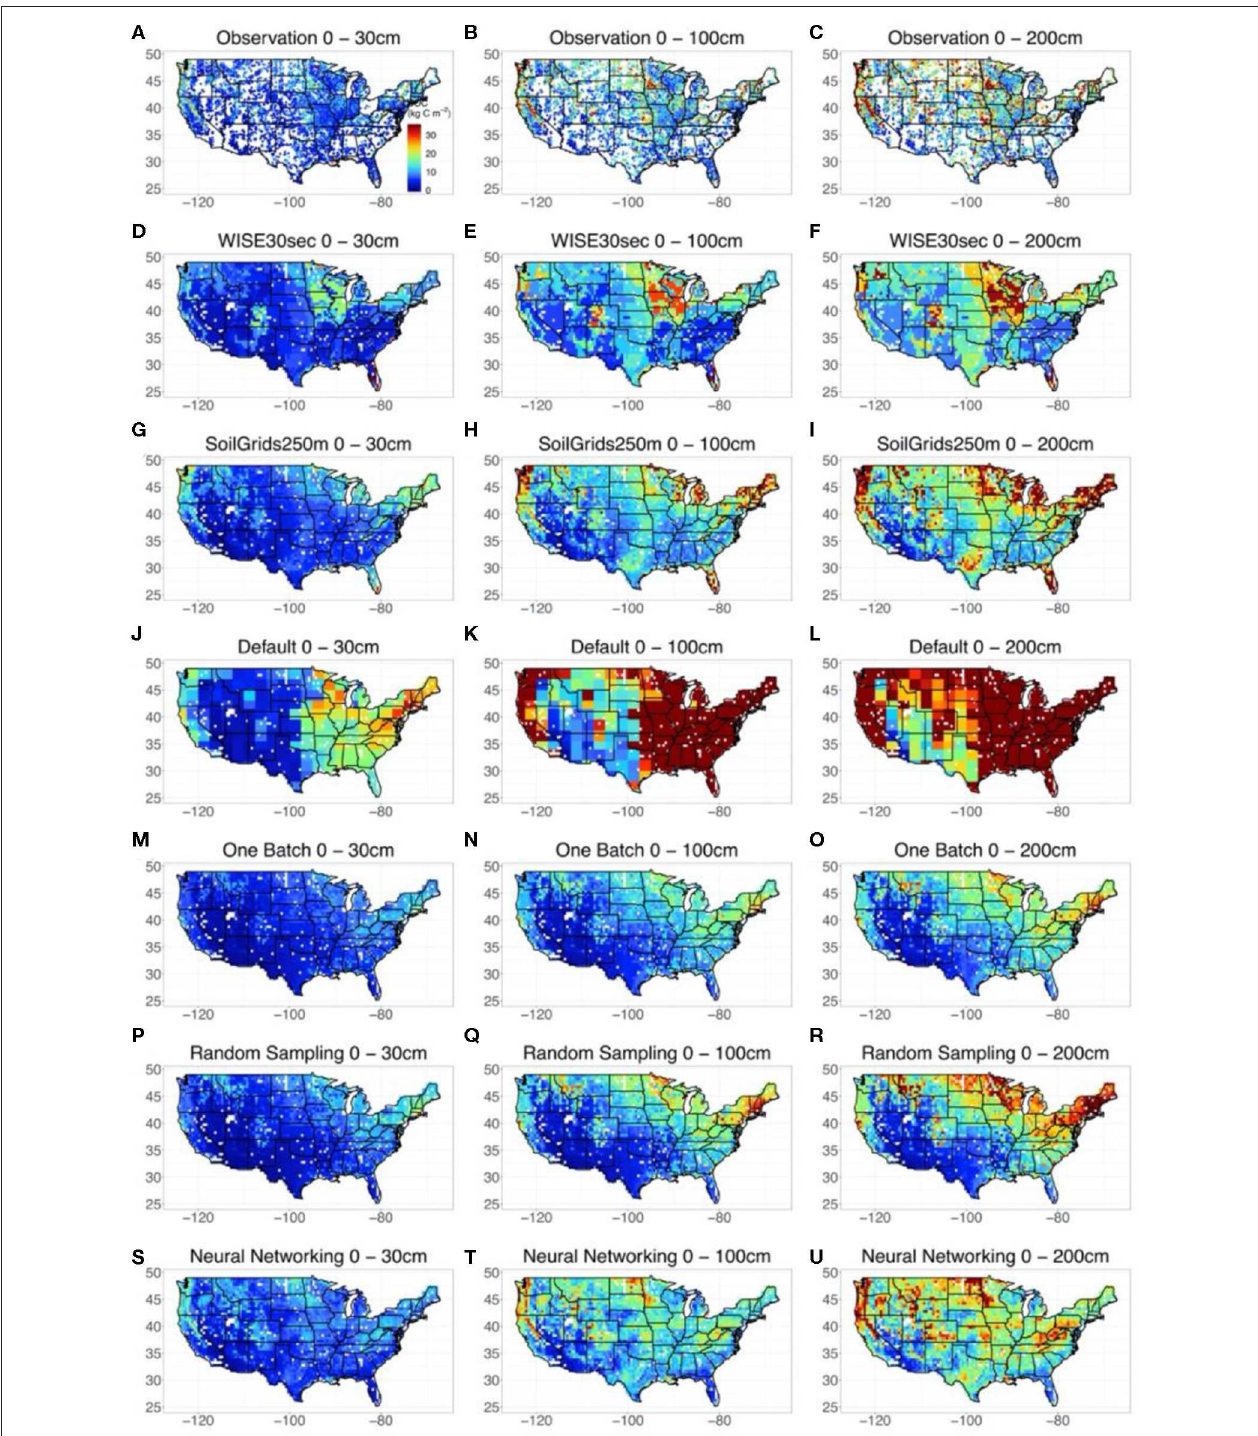
FIGURE 3 | Modeled spatial and vertical SOC distribution across the Conterminous United States by different methods and datasets. Three depth intervals were presented, which were 0–30, 0–100, and 0–200cm respectively. Because the site-by-site method obtained an almost linear agreement between observed and modeled SOC content, the estimations of SOC content distribution at each site by the site-by-site method was taken as observations for comparison. The results of WISE30sec and SoilGrids250m were also presented as references. The uncertainties of the simulation by the random-sampling method and one-batch method were shown in Figure S4